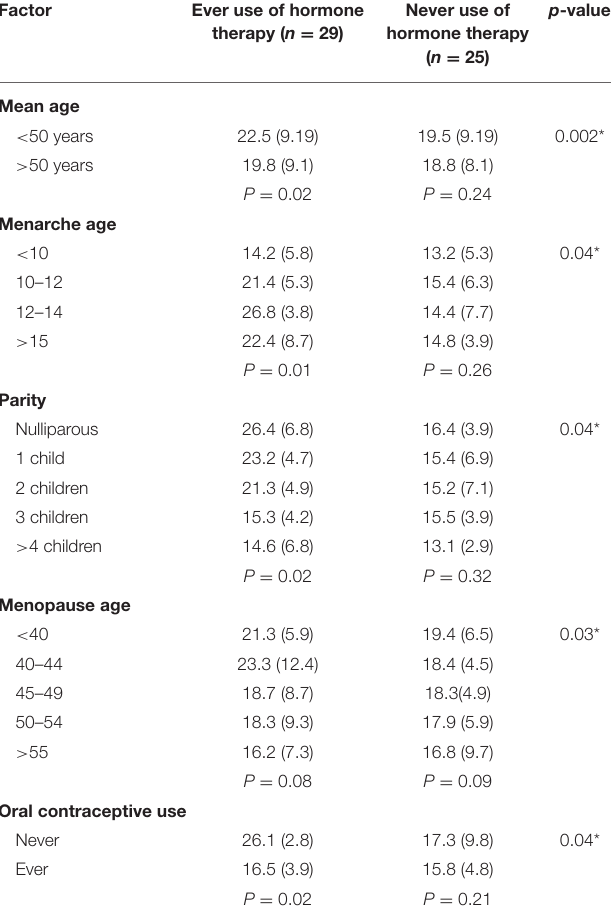
TABLE 6 | Serum 25-OH VD concentrations according to reproductive and menstrual factors by hormone therapy ( n = 54). Factor Ever use of hormone therapy ( n =